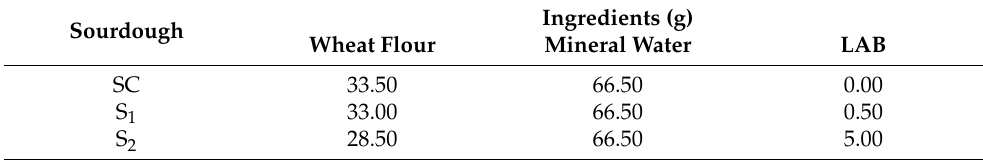
Table 1. Sourdough ingredients per 100 g.